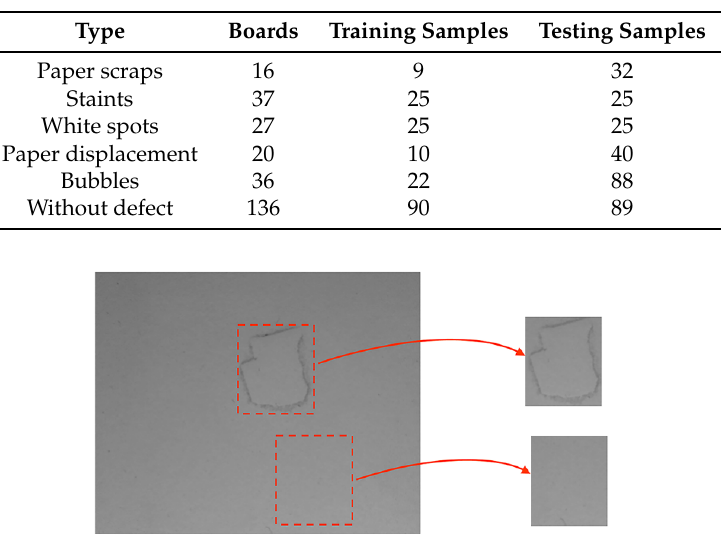
Table 1. Defect type and number of samples analyzed.